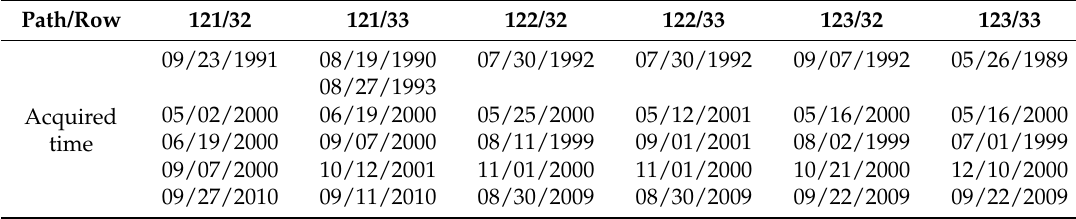
Table 1. TM/ETM+ images that were used in this study. The acquisition dates comprise the year, month and day. All of the images for 2000 were ETM+ images, whereas those for 1990 and 2010 were TM images. The images that were acquired on 27 August 1993 for 121/33 were used to complement areas that were influenced by cloud